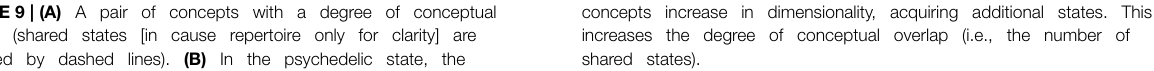
concepts increase in dimensionality, acquiring additional states. This increases the degree of conceptual overlap (i.e., the number of shared